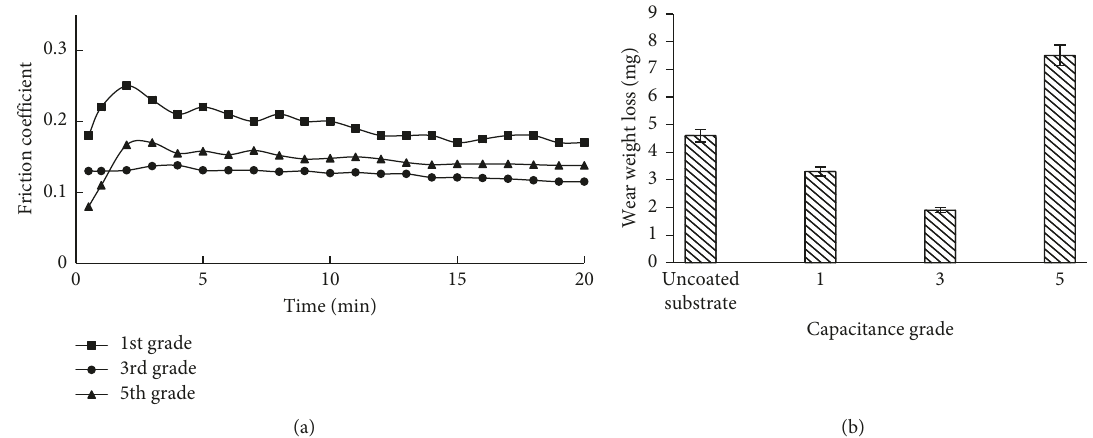
Figure 11: Effect of capacitance on (a) friction coefficient and (b) wear weight loss (pipe diameter of electrode is Φ 1.8, and capacitance is the 3rd